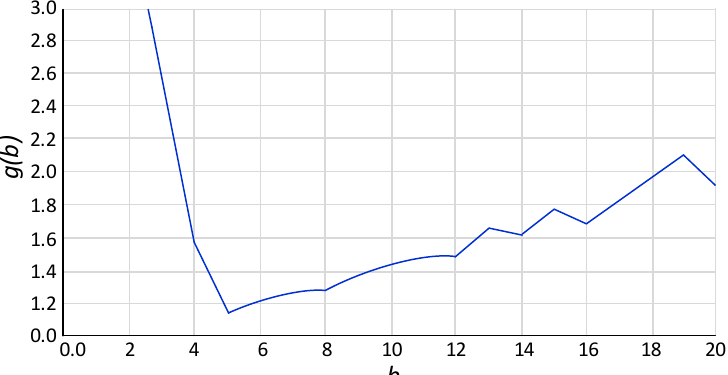
Figure 7. The relationship between the evaluation function g ( b ) and the b value.